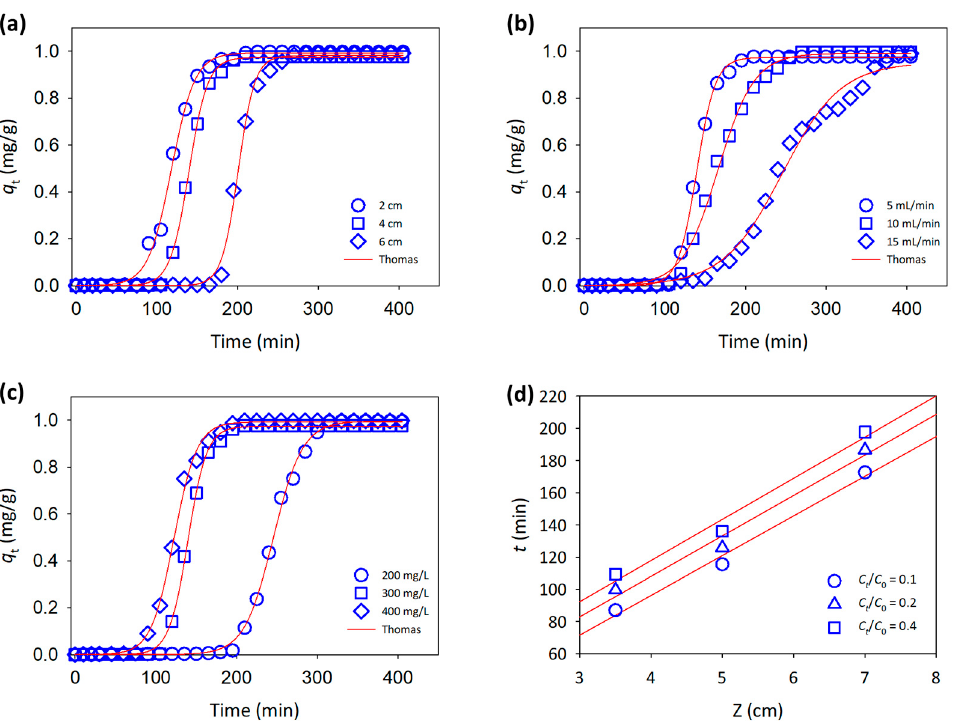
Figure 4. Adsorption of MB onto a functionalized 3D printed column with different controlled parameters: ( a ) different column bed heights, ( b ) different influent flow rate, ( c ) different initial influent concentration, and ( d ) linearized BDST model fit at different service times.